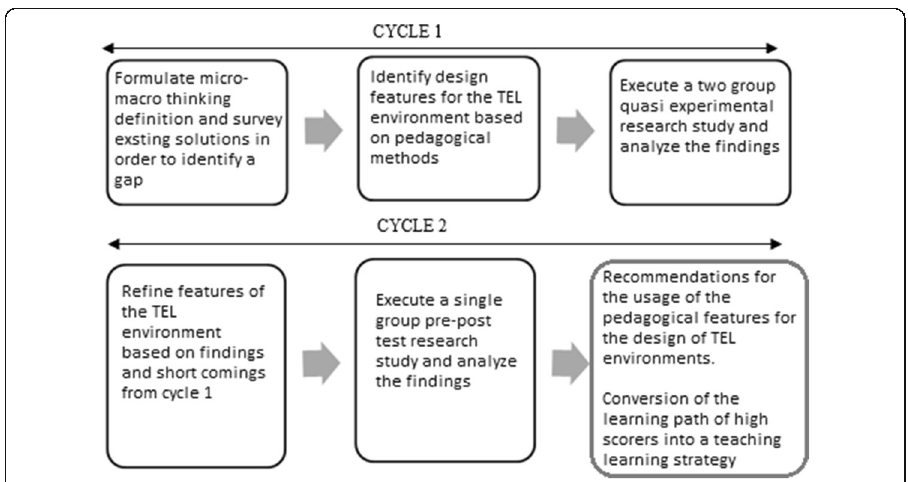
Fig. 1 Design-based approach for developing our TEL